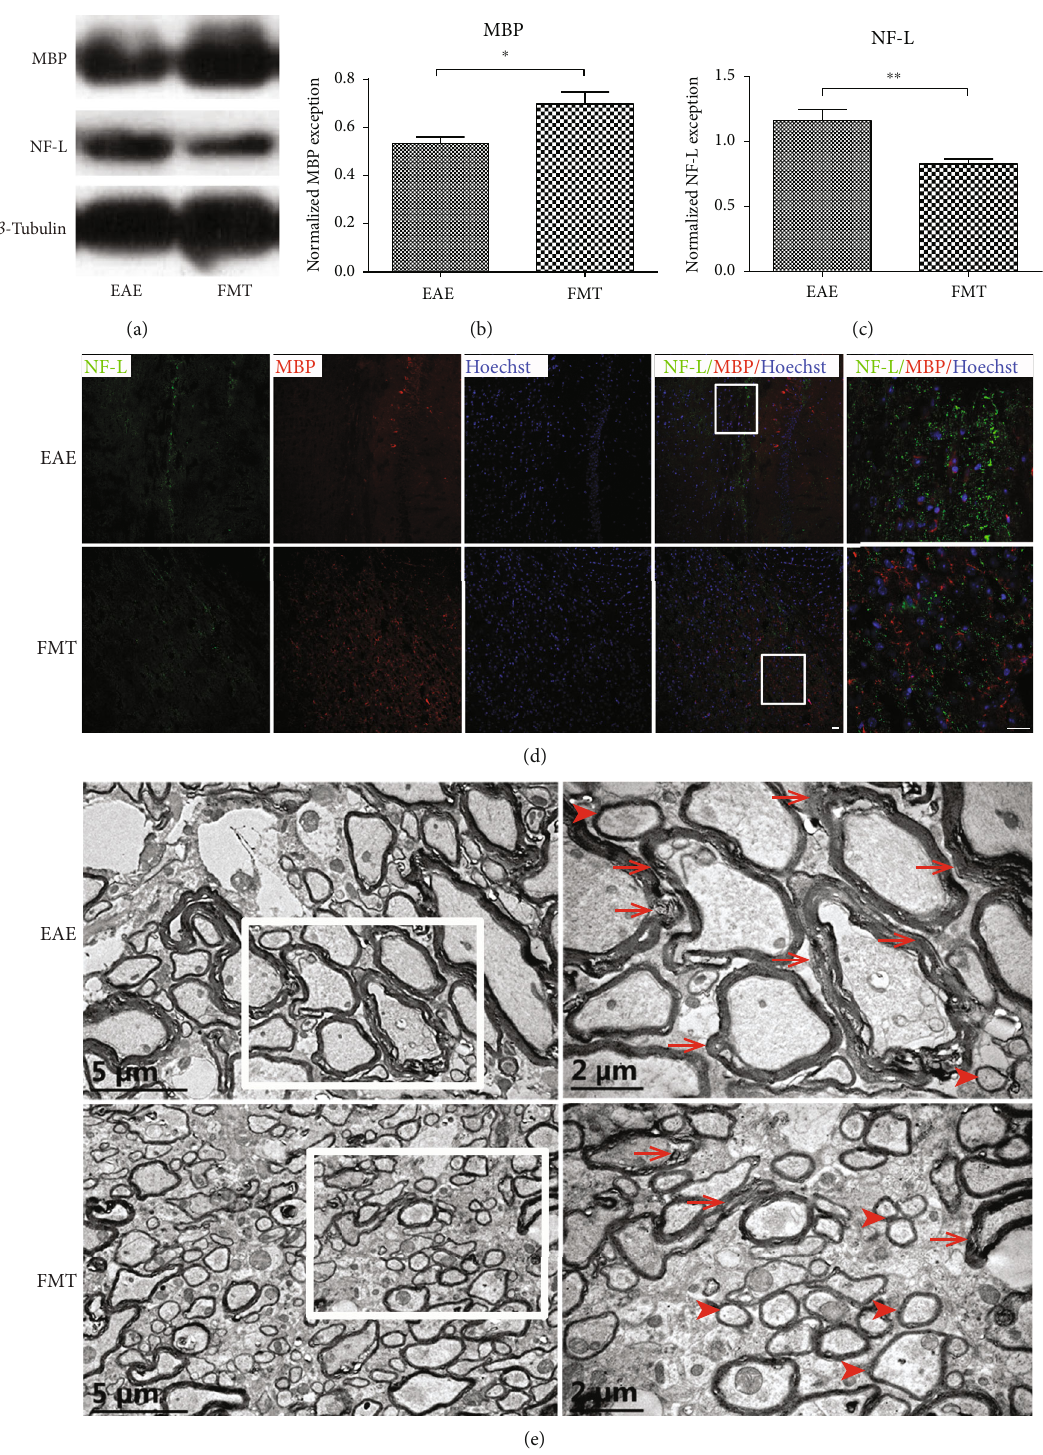
Figure 4: FMT confers protection on myelin and axons in EAE. (a) MBP and NF-L protein expression in the brain of EAE controls and FMT- treated EAE mice shown by Western blot with β -tubulin as loading control. (b, c) Charts of quanti fi ed Western blot results showing increased levels of MBP (b) and decreased levels of NF-L (c) expression (normalized by β -tubulin) after FMT treatment ( mean ± SEM ; n = 6 /group; ∗ p < 0 : 05 and ∗∗ p < 0 : 01 ). (d) Immuno fl uorescence imaging of MBP (green) and NF-L (red) expression in the corpus callosum of the mouse brain. Nuclear staining was by Hoechst (blue). Each rightmost panel shows a high magni fi cation image of the area inside the white box. Scale bar: 25 μ m. (e) Transmission electron microscopy (TEM) imaging of myelin sheaths in the thoracic spinal cord. Each high magni fi cation image (right) shows the area enclosed by the white box (left). Representative normal and damaged myelin sheaths are indicated by arrowheads and arrows,